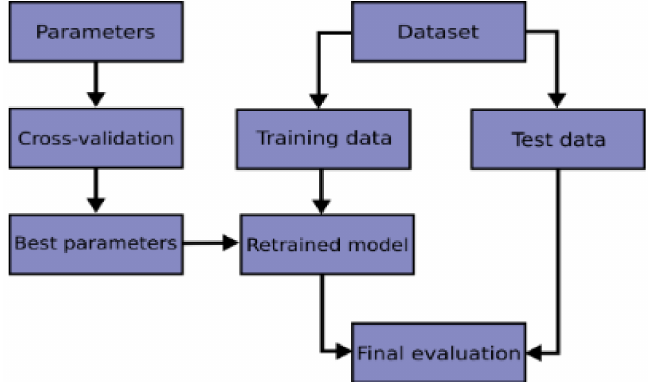
Figure 9. A typical cross-validation workflow in model training